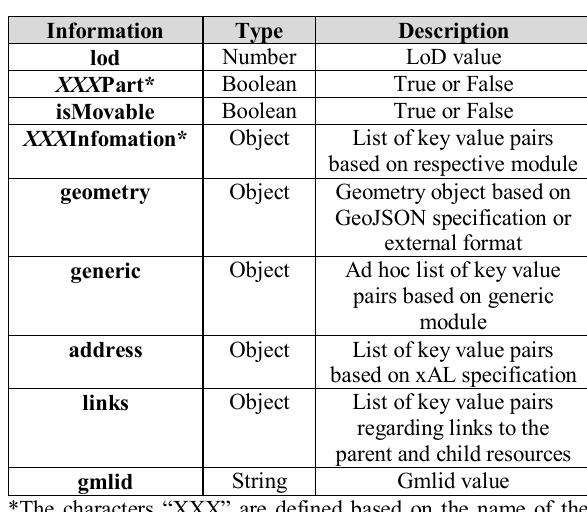
Figure 2. Main Resources of CityGML RESTful Web Service